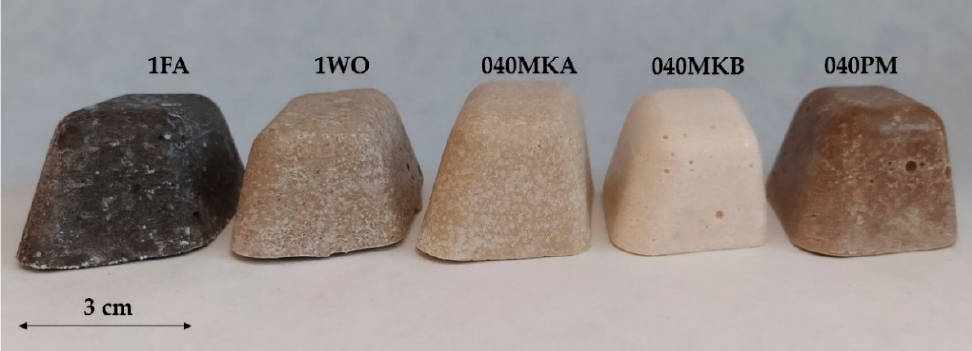
Figure 1. Appearances of the samples of MKPC pastes after 7 days of curing.